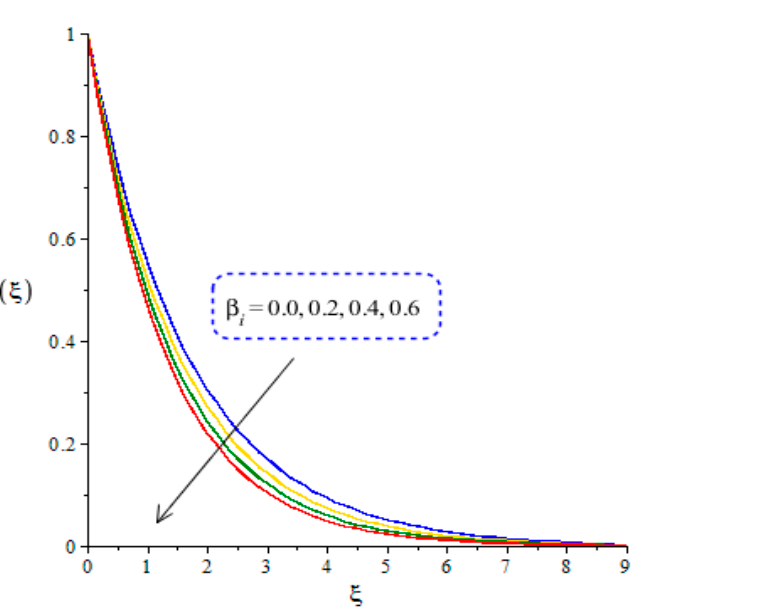
0.3, 𝜖 = 0.3, 𝐹 (cid:3045) = 2.0, 𝑃𝑟 = 204, 𝐸𝑐 = 0.3,𝜑 (cid:2870) = 0.0075, 𝜑 (cid:2869) = 0.002,𝜑 (cid:2871) = 0.005.